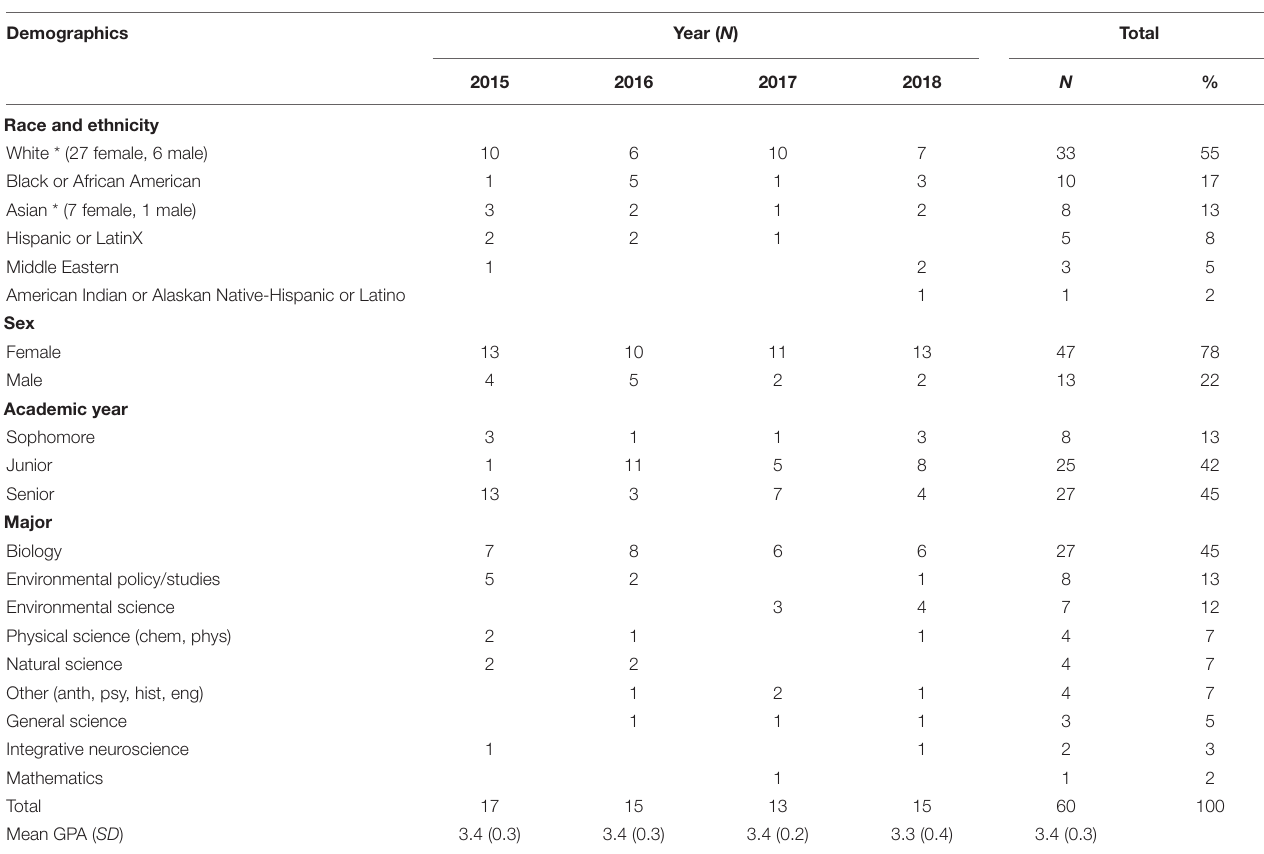
TABLE 1 | Demographics of Project TRUE undergraduate mentors.